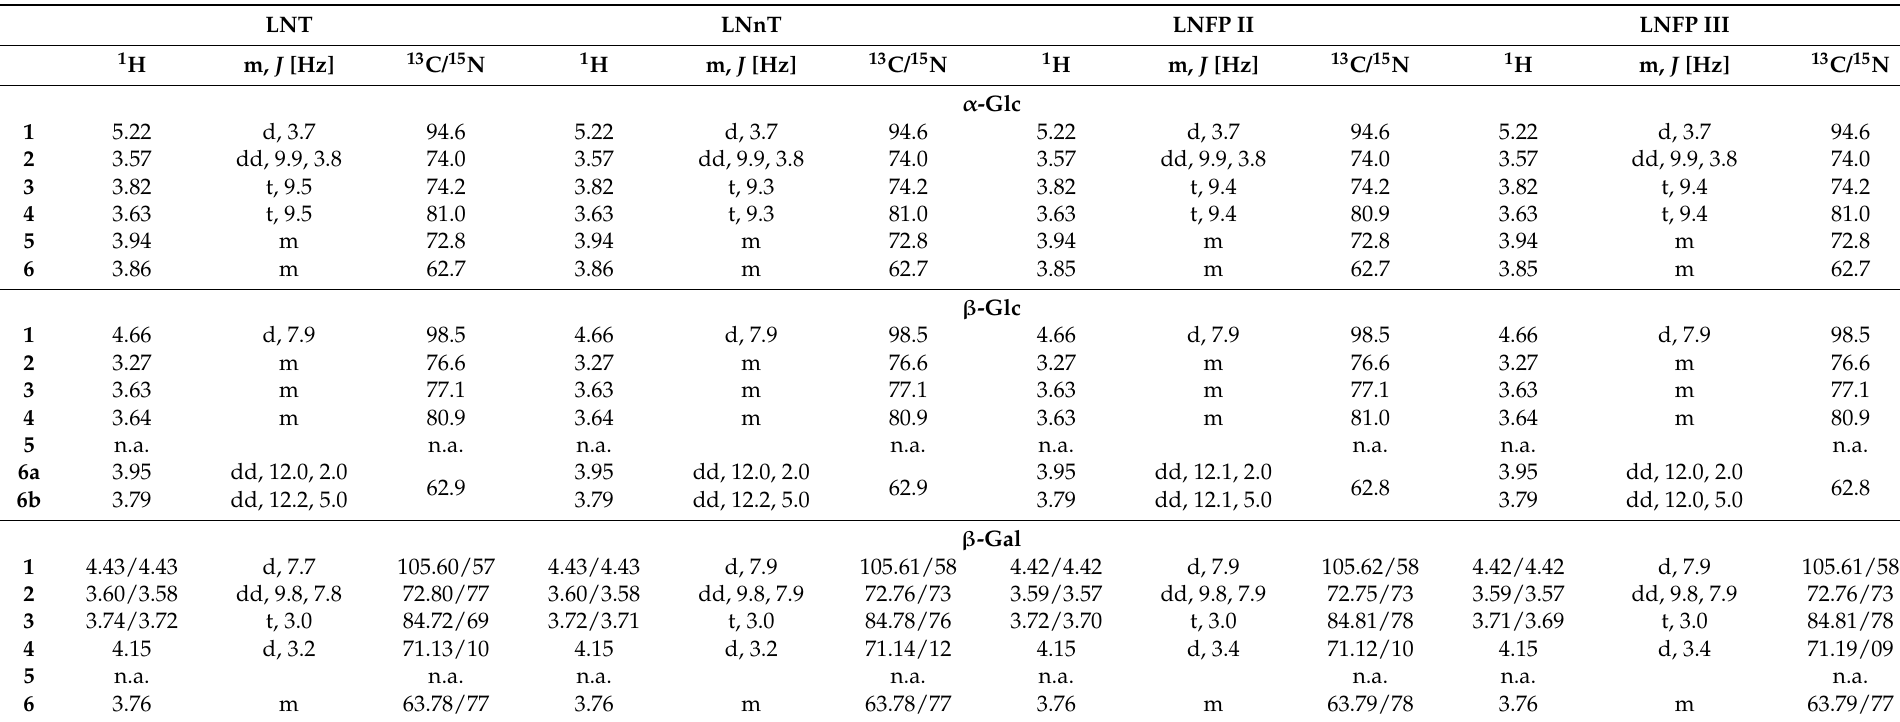
Table 1. The complete 1 H, 13 C, and 15 N resonance assignment of LNT, LNnT, LNFP III, and LNFP III in H 2 O: D 2 O 9:1 v / v solvent at pH